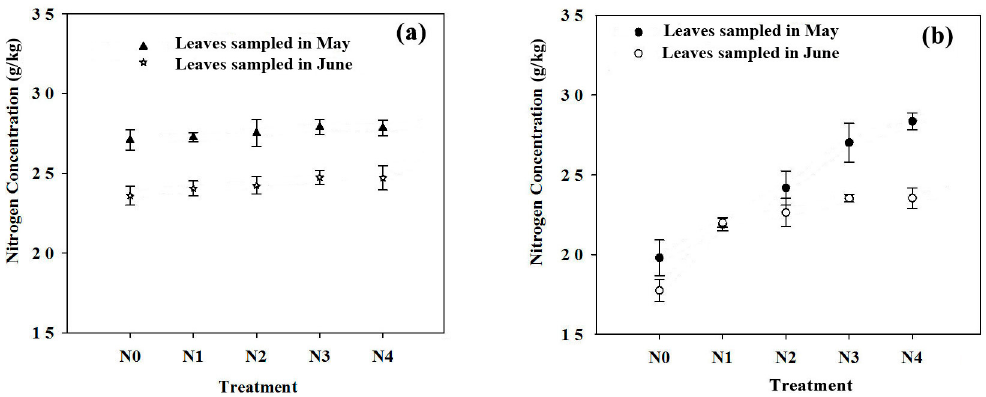
( c ) Figure 4. Contour maps of coefficients of determination for the linear relationship between the three vegetation indices (difference spectral index (DSI, a ), ratio spectral index (RSI, b ), or normalized difference spectral index (NDSI, c )) and chemically-measured leaf N concentration using the spectra measured by the black background. ( a ) ( b ) ( c ) Figure 5. Contour maps of coefficients of determination for the linear relationship between three vegetation indices (DSI ( a ); RSI ( b ); or NDSI ( c )) and the chemically-measured leaf N concentration using the spectra measured by the white background . 3.4. Two-Year Nitrogen Status as Dependent on the N Treatment